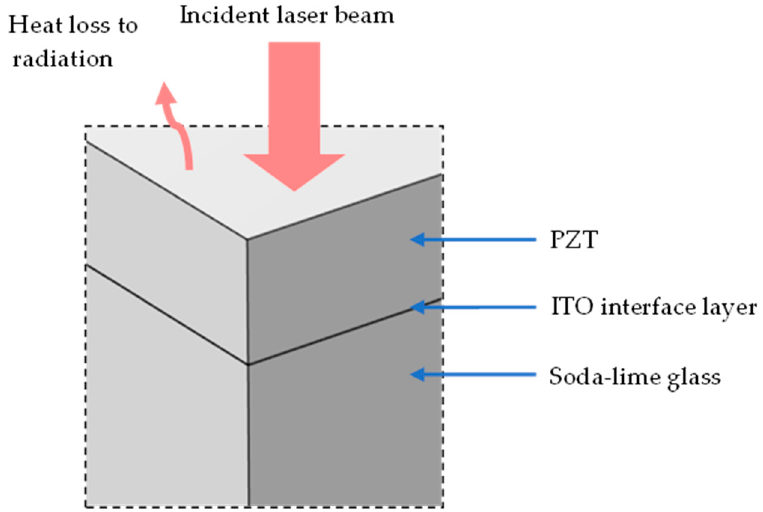
Figure 4. Three-dimensional model geometry used in the heat transfer simulation of laser sinter- ing.